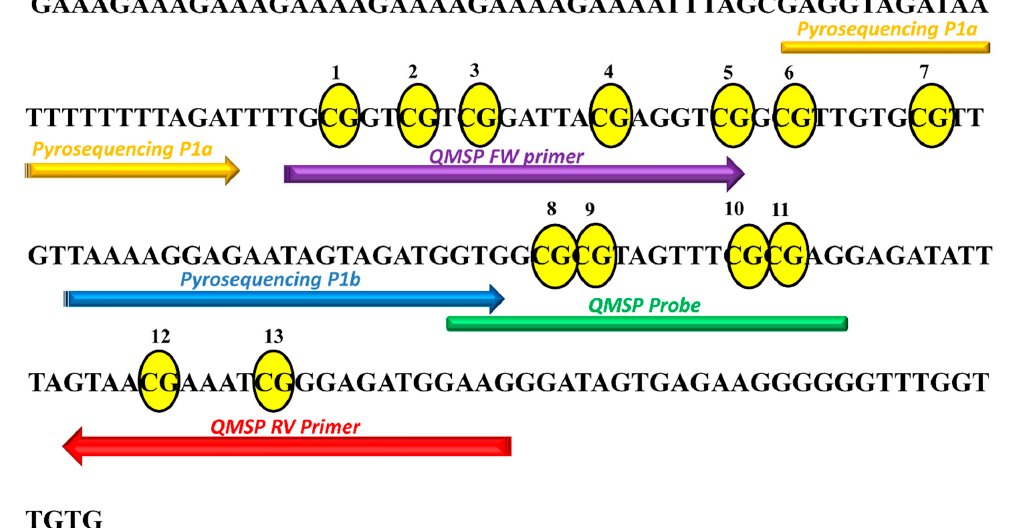
Figure 1. Sequence of KEAP1 P1 promoter region (-291 -89 bp from the TSS, transcription starting site) scanned by QMSP and pyrosequencing. CpGs are marked as yellow circles and numbers are given to the CpGs from 5 ′ to 3 ′ of positive strand of the KEAP1 gene. The primers used for QMSP and pyrosequencing analysis are indicated.